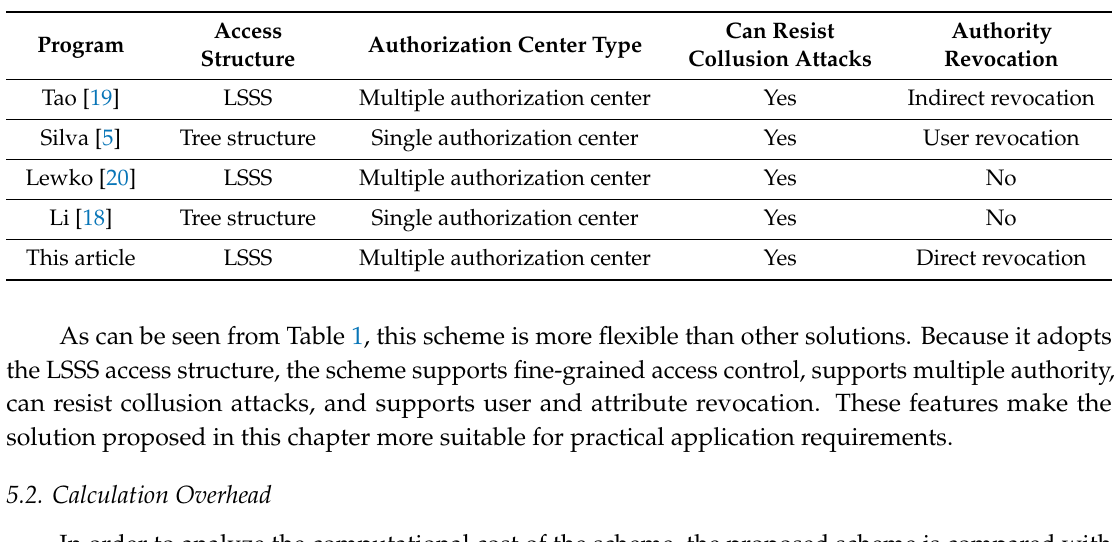
Table 1. Flexibility comparison of the